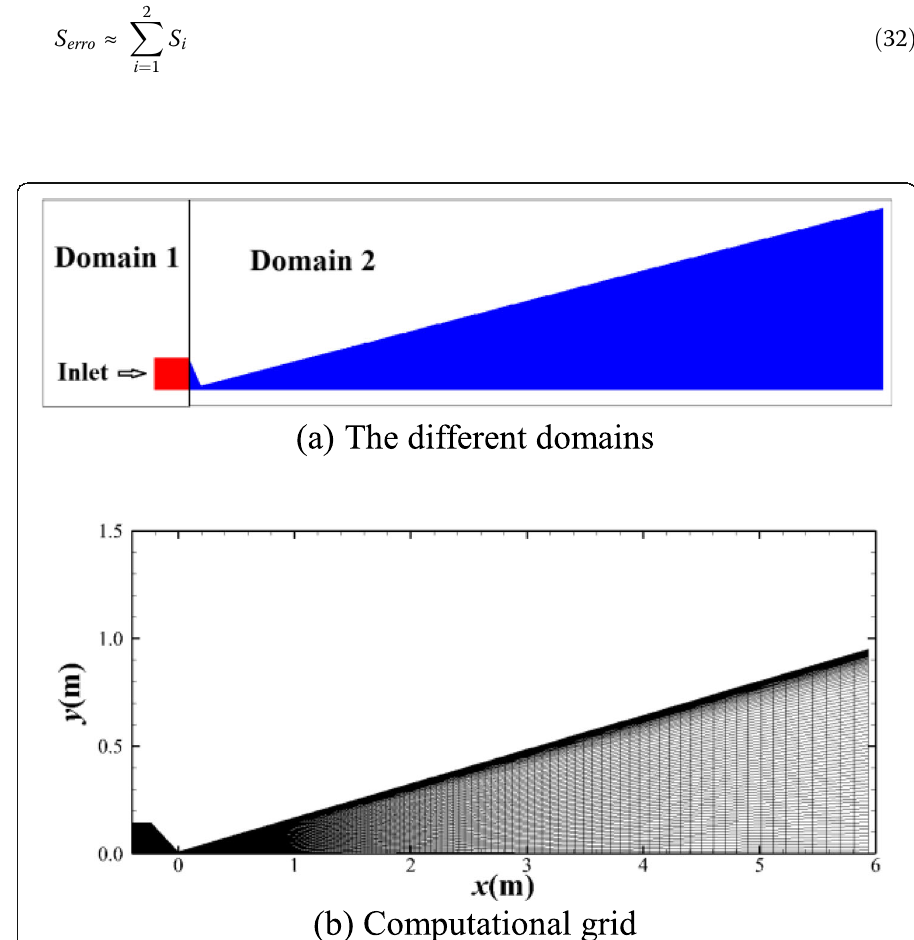
Fig. 1 Computational domain. ( a ) The different domains. ( b ) Computational